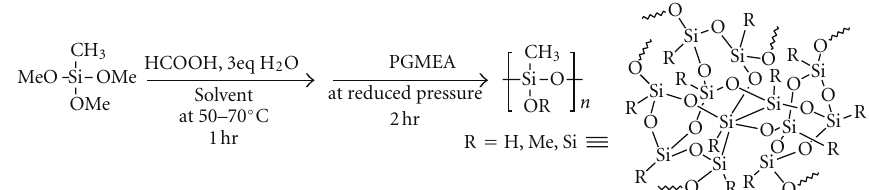
Figure 2: Synthesis of polymethylsilsesquioxane